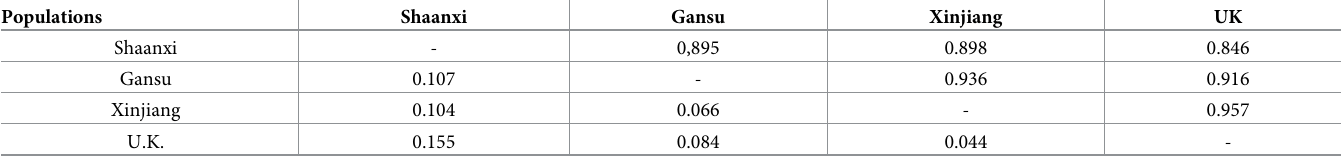
The data in brackets represent the proportion of isolates in each lineage group relative to the whole population.